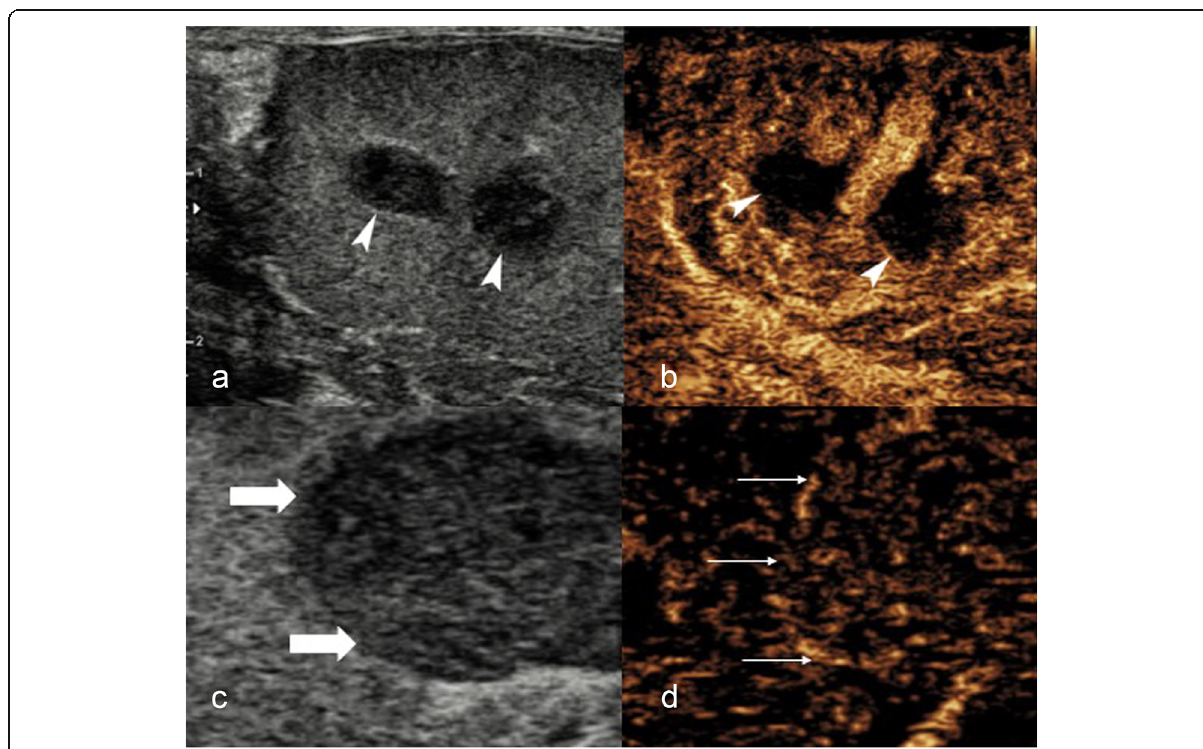
Fig. 6 CEUS findings of iatrogenic penetrating testicular injury post-biopsy. B-mode US image ( a ) obtained 24 h following core biopsy of the testis demonstrating two hypoechoic lesions within the central testis (arrowheads), which have typical appearances of intratesticular haematomas. CEUS ( b ) confirmed the avascular nature of the suspected haematomas (arrowheads). A separate patient with a histologically proven testicular tumour. For comparison, ( c ) B-mode shows a well-defined hypoechoic lesion (thick arrow). d CEUS demonstrated intrinsic enhancement (thin arrow) in keeping with a testicular tumour, unlike an avascular